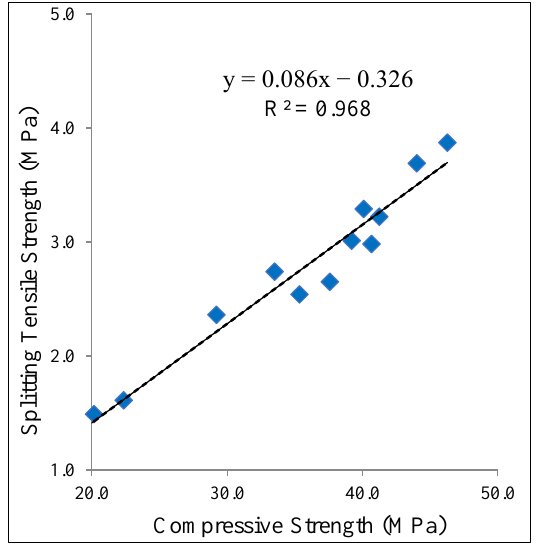
Figure 2. Compressive strength correlations with splitting tensile strength.